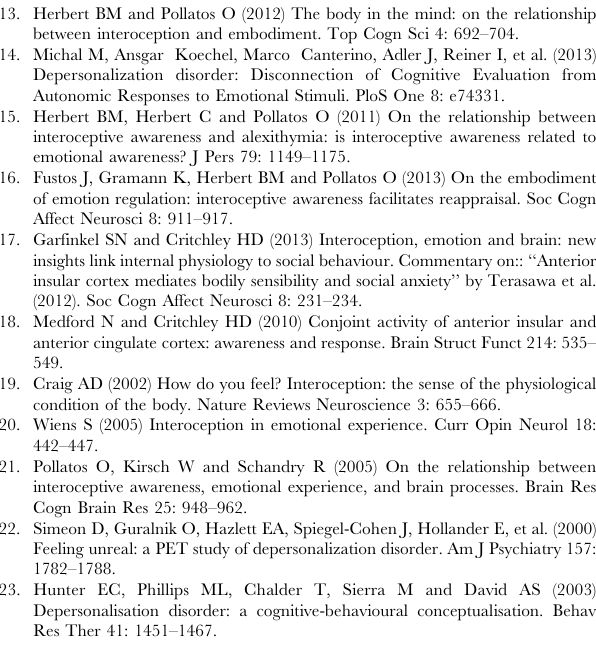
Table S1 Comparison of DPD patients taking antide- pressants with those DPD patients free form antide- pressants. Table S2 Comparison of DPD patients with high versus low anxiety. Table S3 Comparison of DPD patients with high versus low